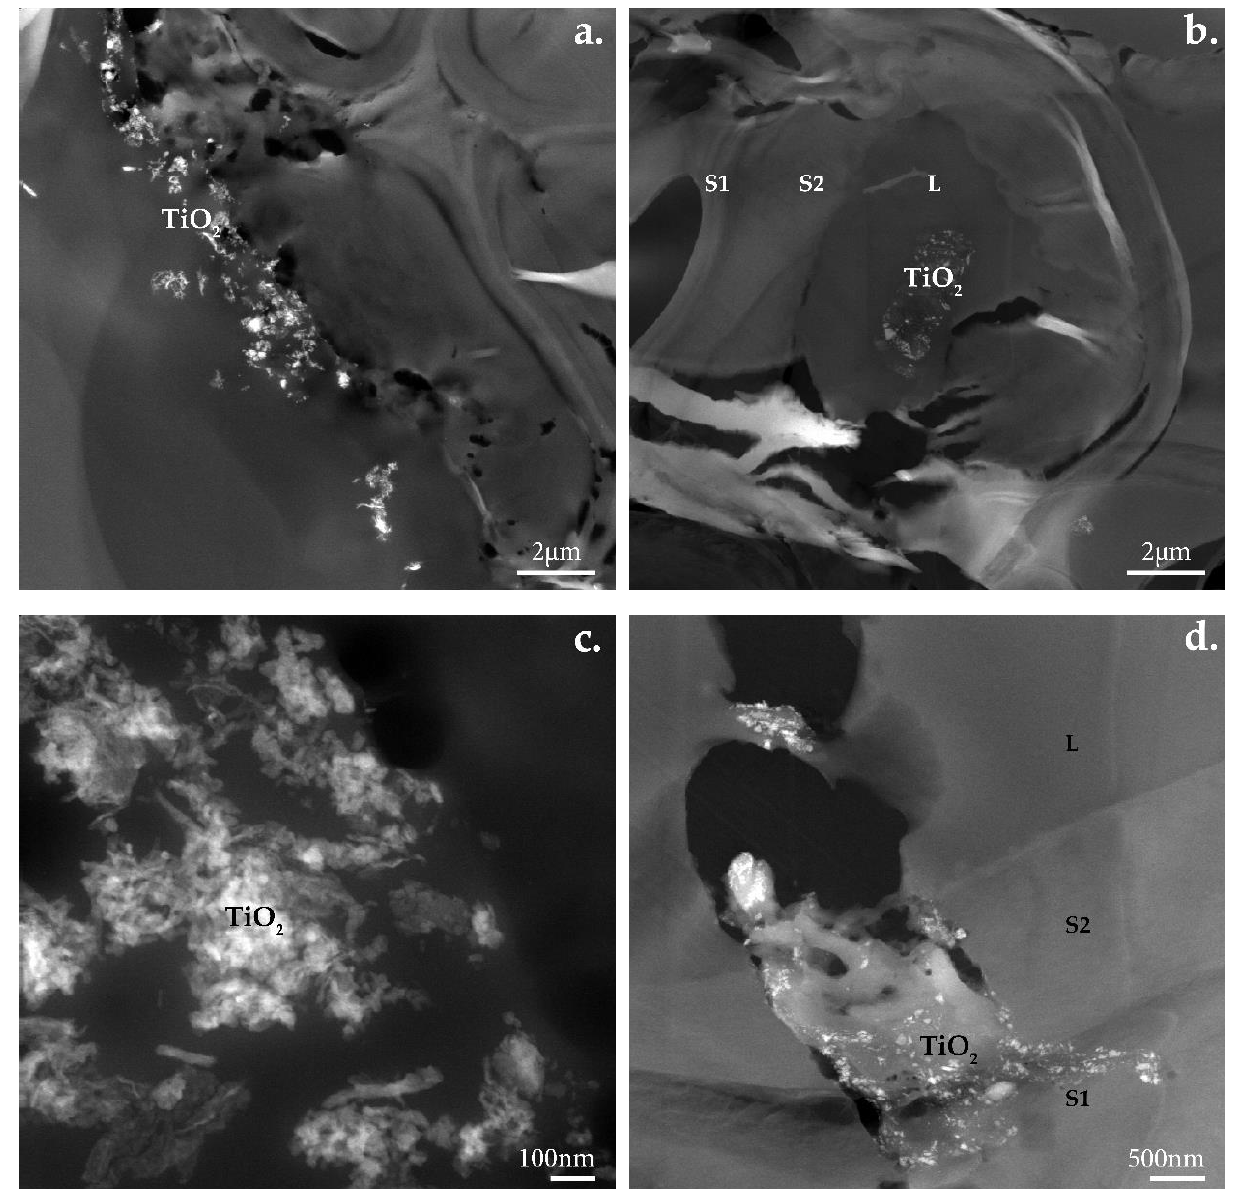
Figure 17. TEM micrographs of TiO 2 coated samples before irradiation: ( a , c ) beech and ( b , d ) pine wood’s cell wall ultrastructure.